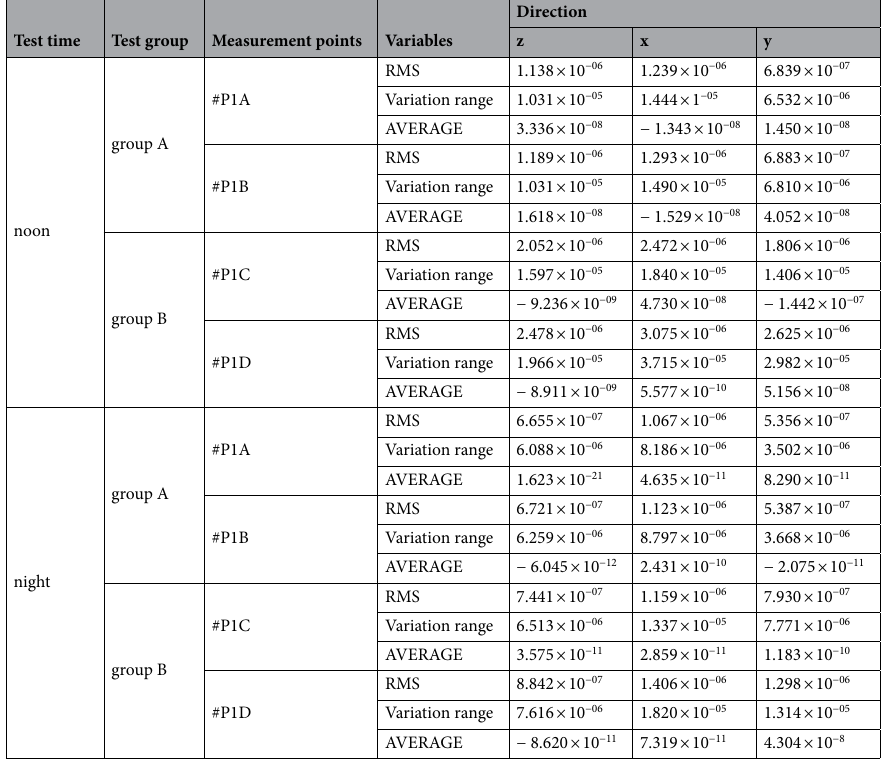
Table 2. Root-mean-square value, variation range and average value of the measured velocity signals